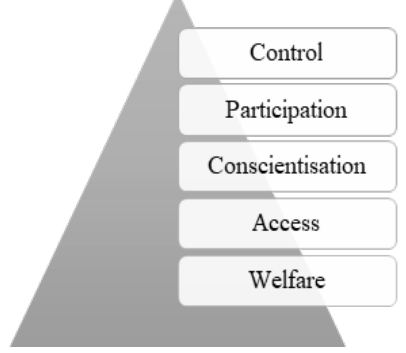
Figure 1: Longwe (1991) women’s empowerment framework